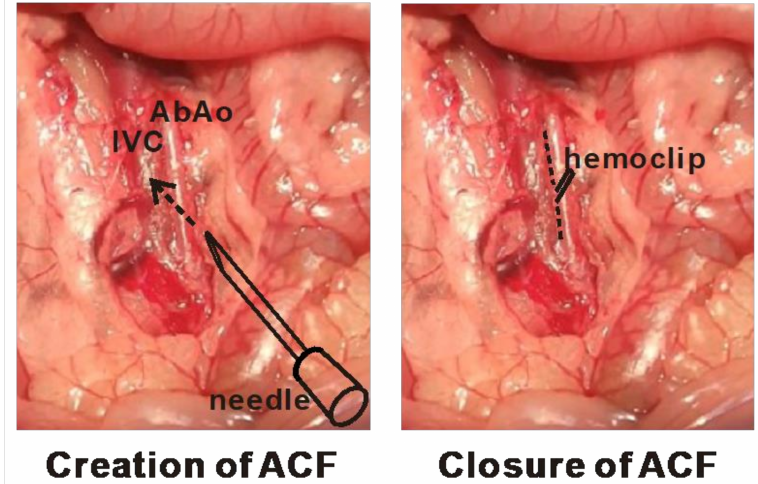
Figure 6. Schematic diagrams showing the procedures to create and to close an aortocaval fistula (ACF). The abdominal aorta (AbAo) was punctured with an 18-gauge needle. The needle was inserted into the lateral wall of the aorta and advanced medially through the medial wall and into the inferior vena cava (IVC) ( left panel ). To close an ACF, the fistula was identified after dissecting the soft tissue between the abdominal aorta and the IVC (dash line) and then clamped with a hemoclip ( right panel